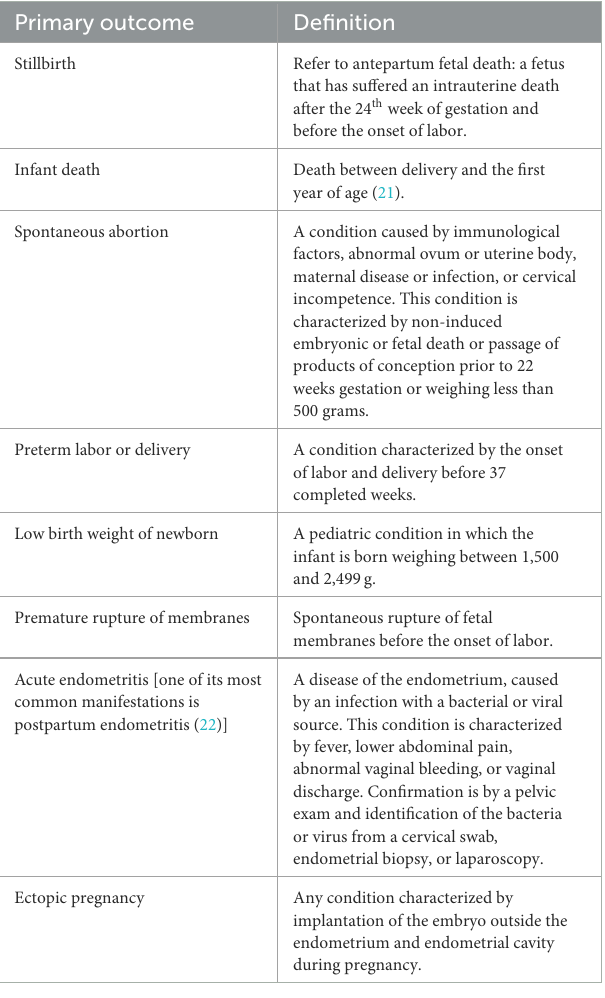
TABLE 1 Definitions of primary outcomes based on the international classification of diseases (19,